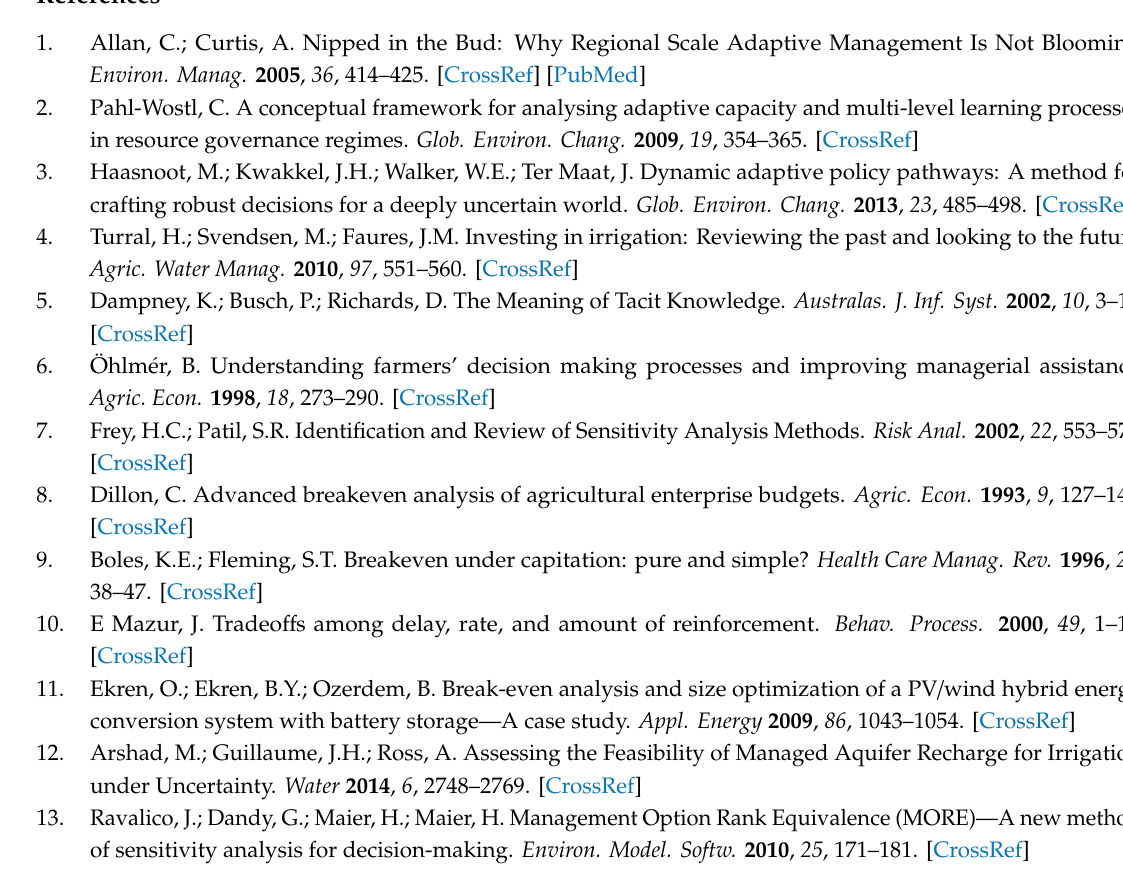
Figure A2. Participants’ indication of the most important characteristic of reuse use water before and after discussion.